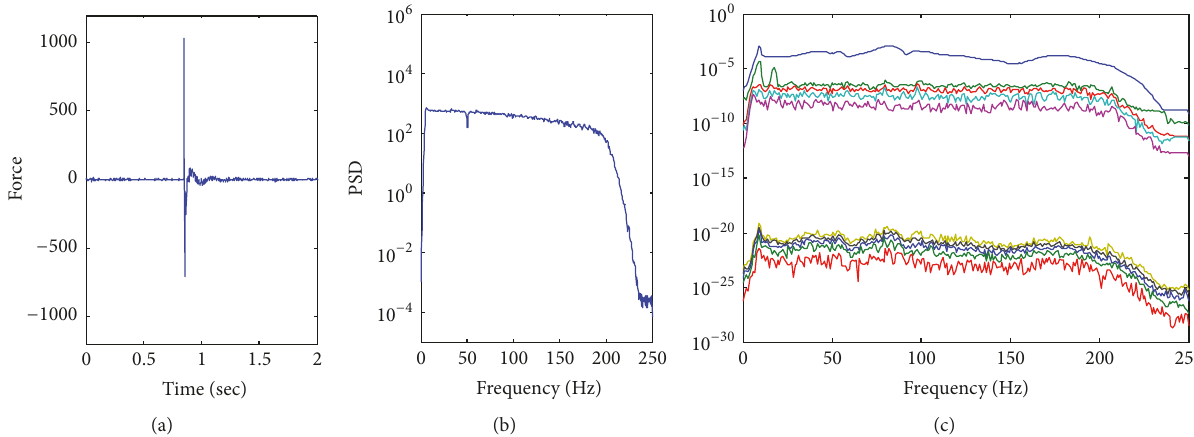
Figure 10: (a) Time series and (b) power spectrum of one impact recorded by the hammer and (c) response power spectrum recorded by the